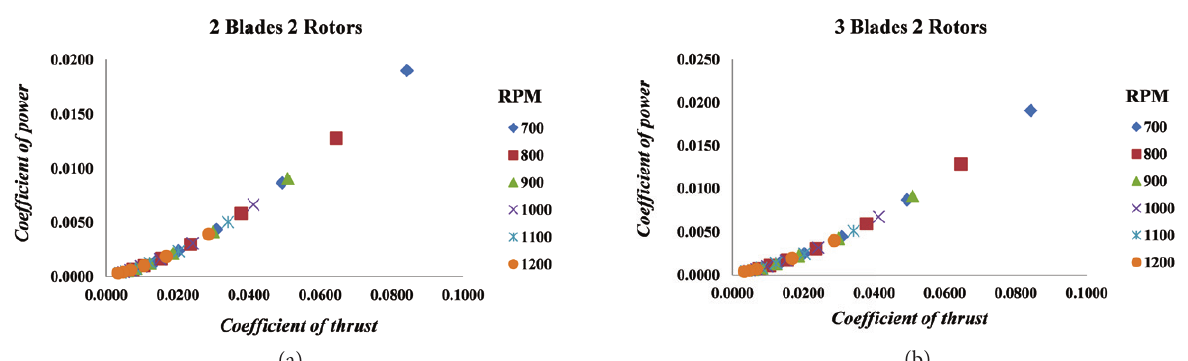
systems(a) Figure 6. Relationship between coeffi cient of thrust C T , and coeffi cient of power C P , for 2-blade and 3-blade coaxial rotor